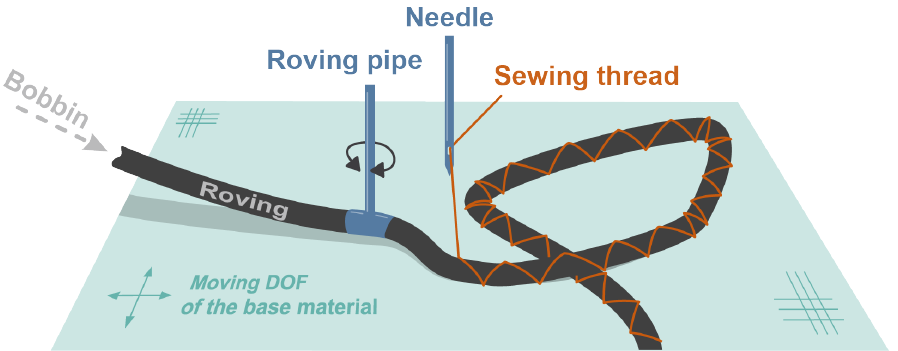
Figure 1. Basic principle of the TFP process